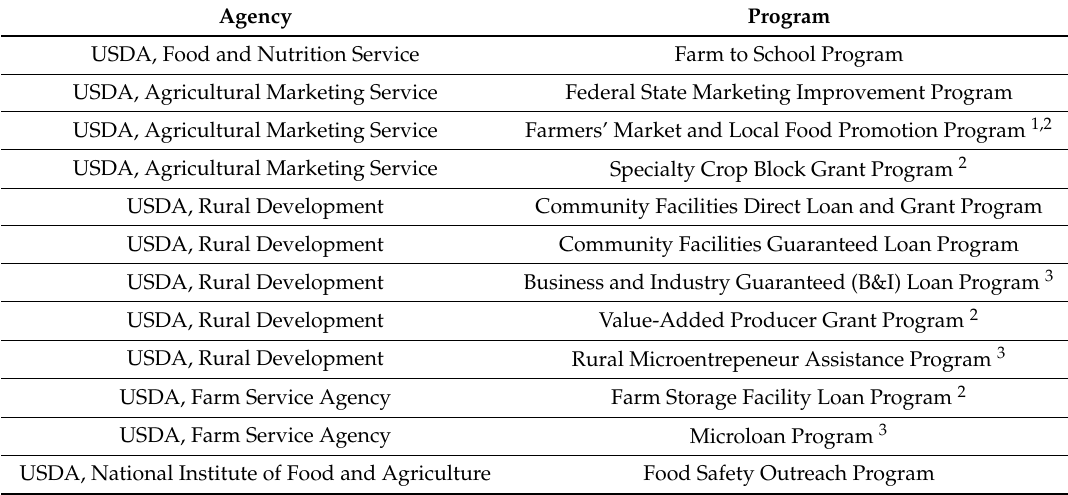
Table 1. USDA agencies administering programs that address barriers to local food